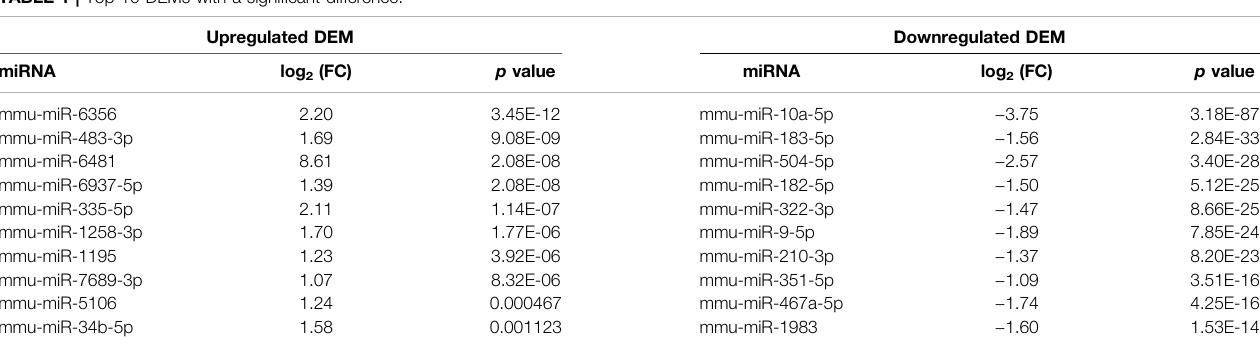
TABLE 1 | Top 10 DEMs with a signi fi cant difference. Upregulated DEM Downregulated DEM miRNA log 2 (FC) p value miRNA log 2